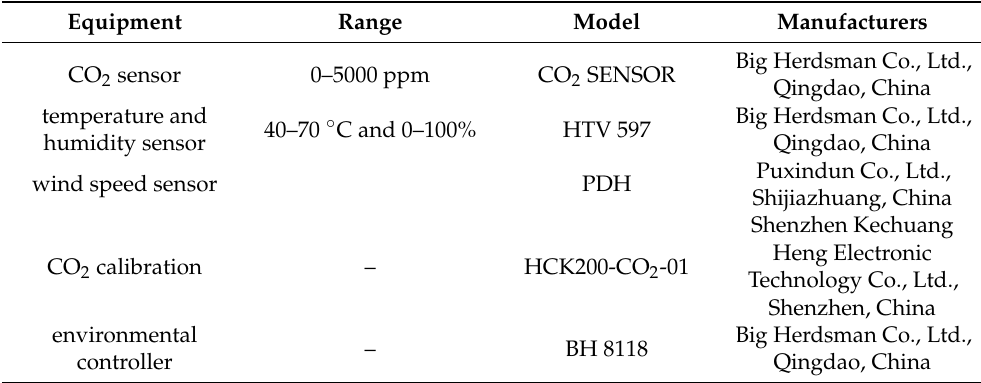
Table 1. The instrument information of the pig house. Equipment